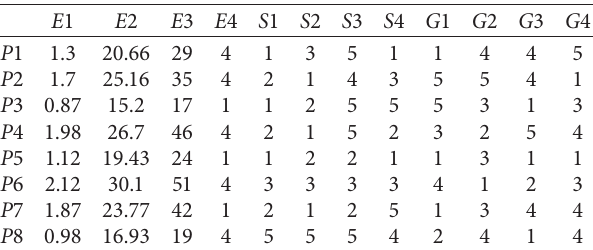
Table 31: Decision matrix in deterministic